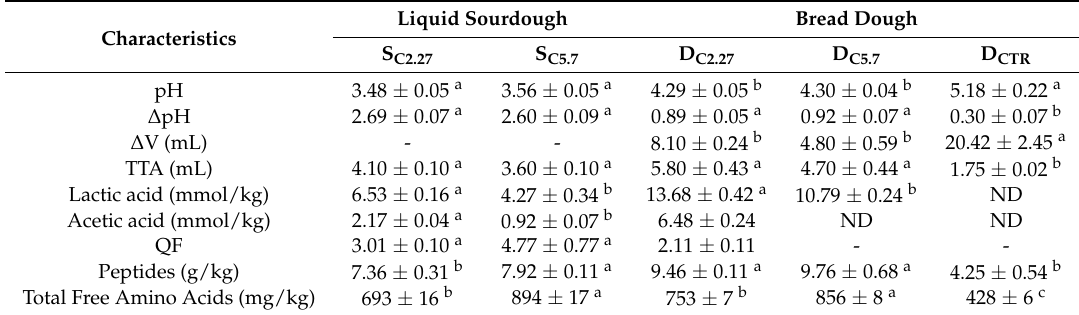
Table 3. Chemicophysical characteristics of liquid sourdoughs (S C2.27 and S C5.7 ) inoculated with starter strains ( L. citreum C2.27 or W. confusa C5.7) and bread doughs started with the liquid sourdoughs (D C2.27 and D C5.7 ) or with baker’s yeast (D CTR ) in laboratory